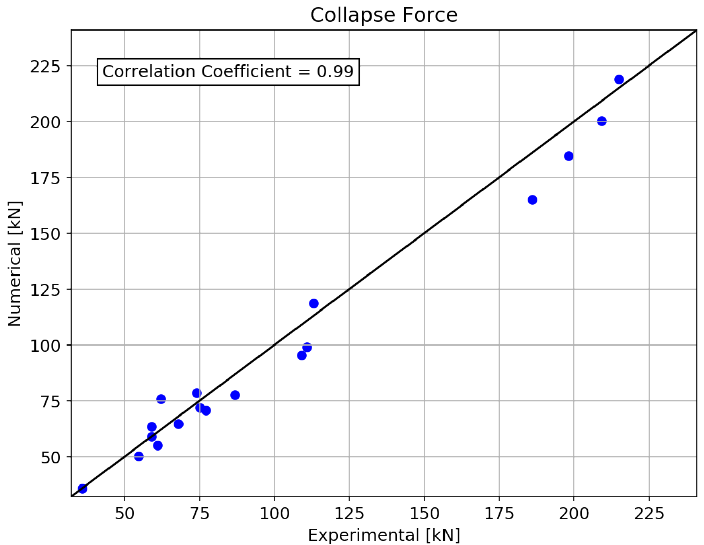
Figure 9. Comparison between numerical and experimental results regarding collapse force.